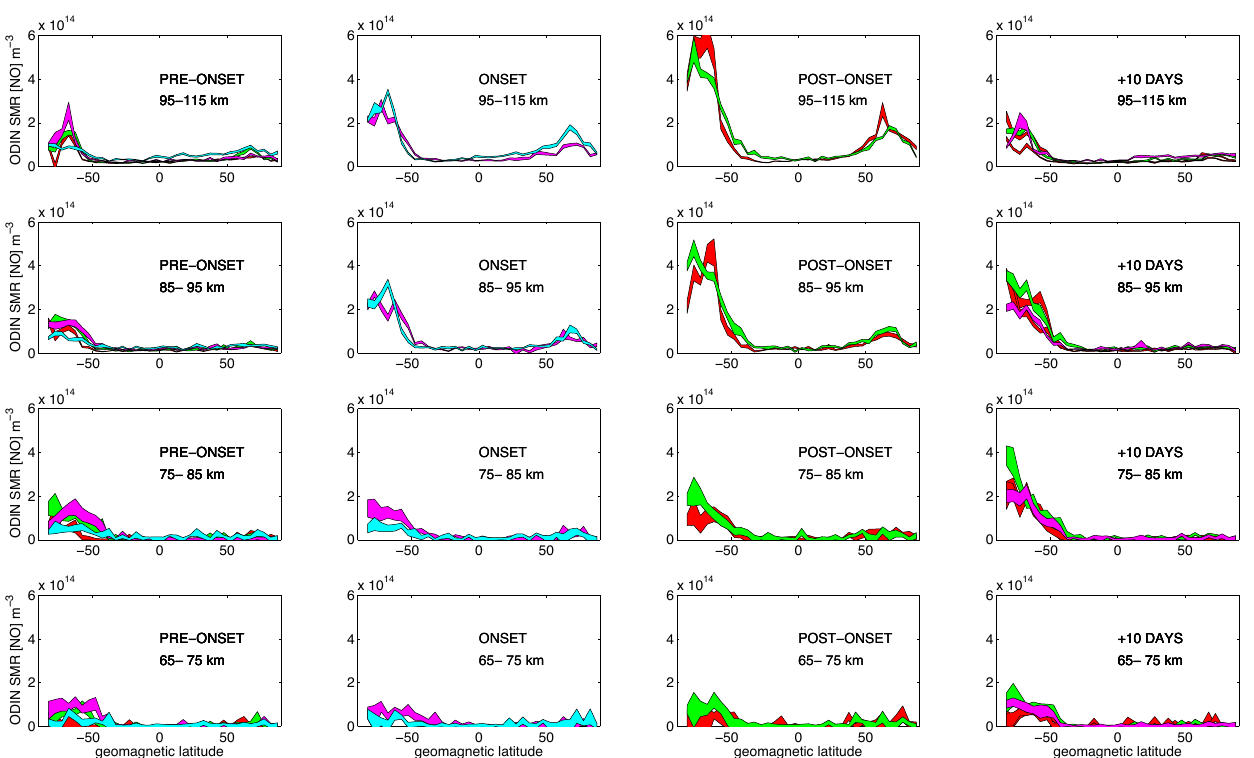
Figure 6. Observations of NO number densities by the Odin-SMR instrument before, during and after the arrival of high-speed solar wind streams during austral winter in 2010, plotted as a function of geomagnetic latitude. Broad, colour-filled lines show values between zonal mean and plus and minus the standard error of the mean. Colours indicate the different events in Table 2: red, 2 May; green, 31 May; magenta,